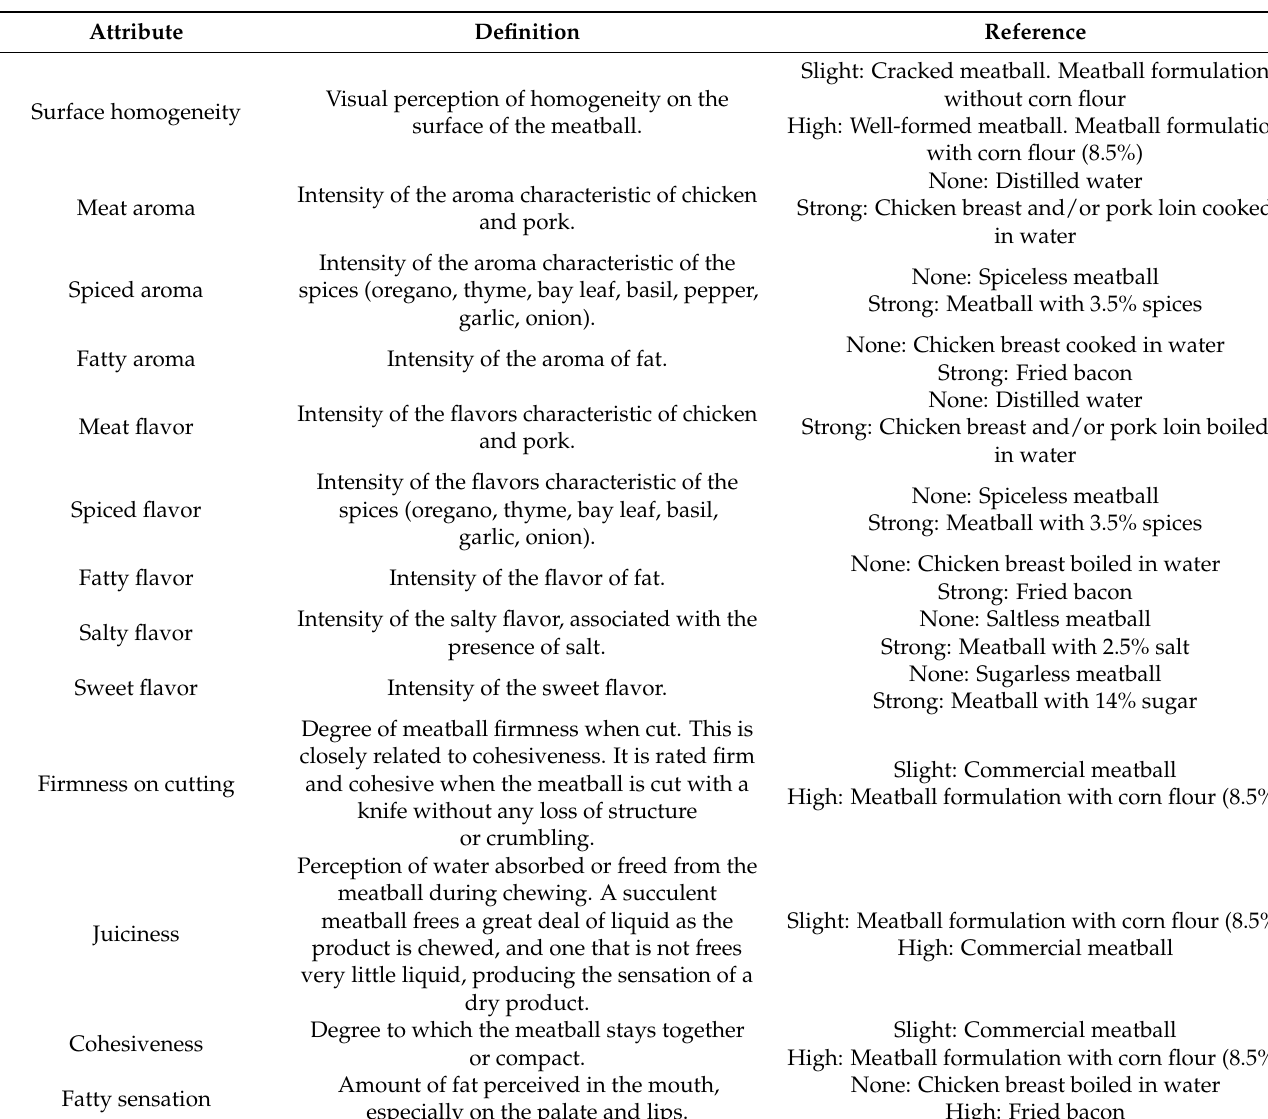
Table 3. Definitions and references of descriptive terms for meatballs, which correspond to the ends of the measurement